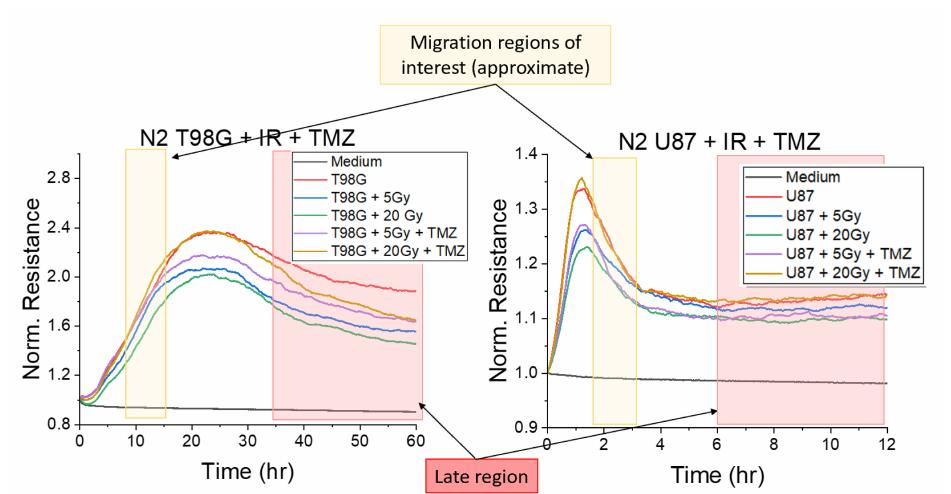
Figure A1. Choice of regions of interest for rate of migration (ROM) and late resistance (LR) analysis of T98G and U87 following treatment. Time frames used for both T98G and U87 were selected for each experiment and rested consistently within the migration region for all trials. The cell behavior was considered in the selection of the migration region. Timescales shown were shortened for ease of visualization.